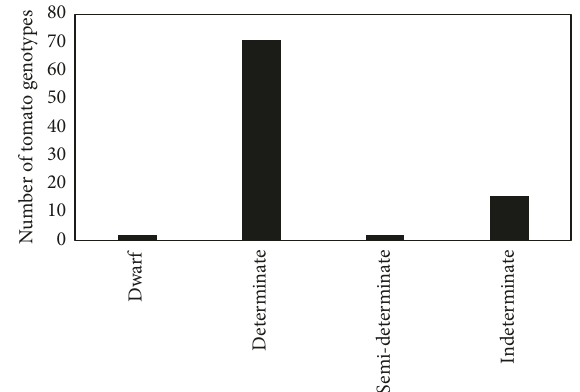
Figure 1: Distribution of tomato genotypes based on their growth habit.